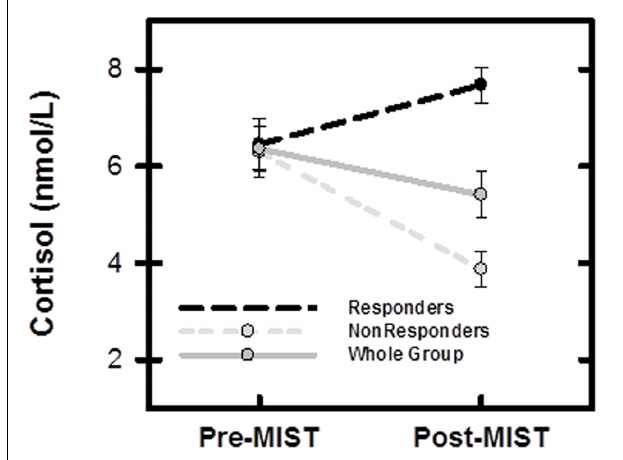
FIGURE 2 | Salivary cortisol measurement (mean and SEM) for entire sample ( N = 52), Responders ( n = 22), and Non-responders ( n = 30). Pre-MIST: immediately prior to scanning session, Post-MIST: 20 min after end of MIST.